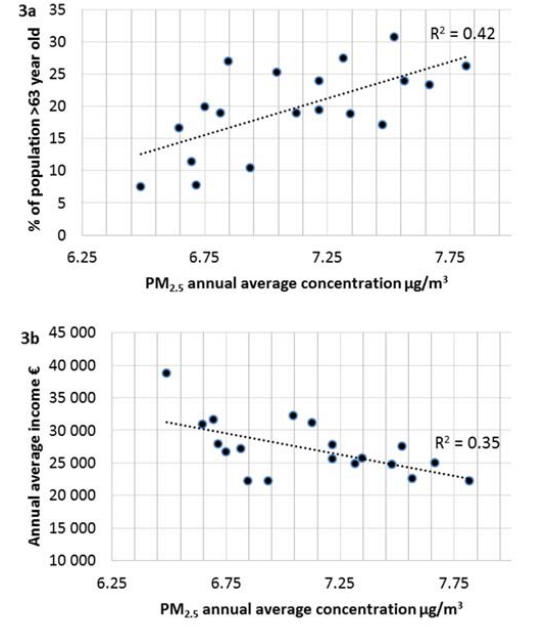
Figure 3. GIS mapped PM 2.5 annual average concentrations in urban Kuopio postal code areas related to ( 3a ) % of population >63 year olds and to ( 3b ) annual average